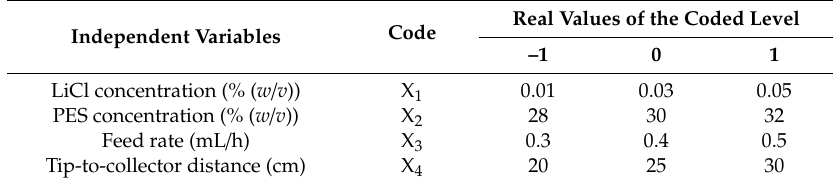
Table 2. Experimental range and coded levels of the independent variables for fabricating PES nanofibers. Independent Variables